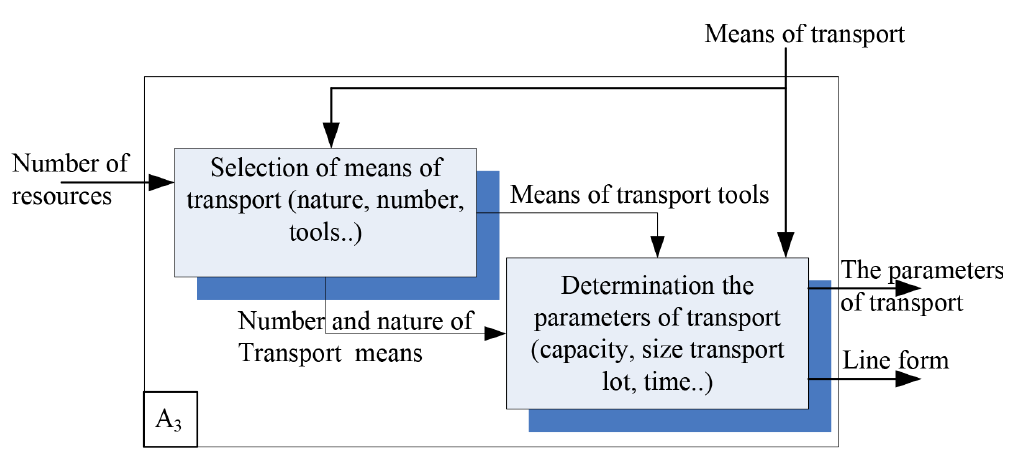
Figure 8. Activity A